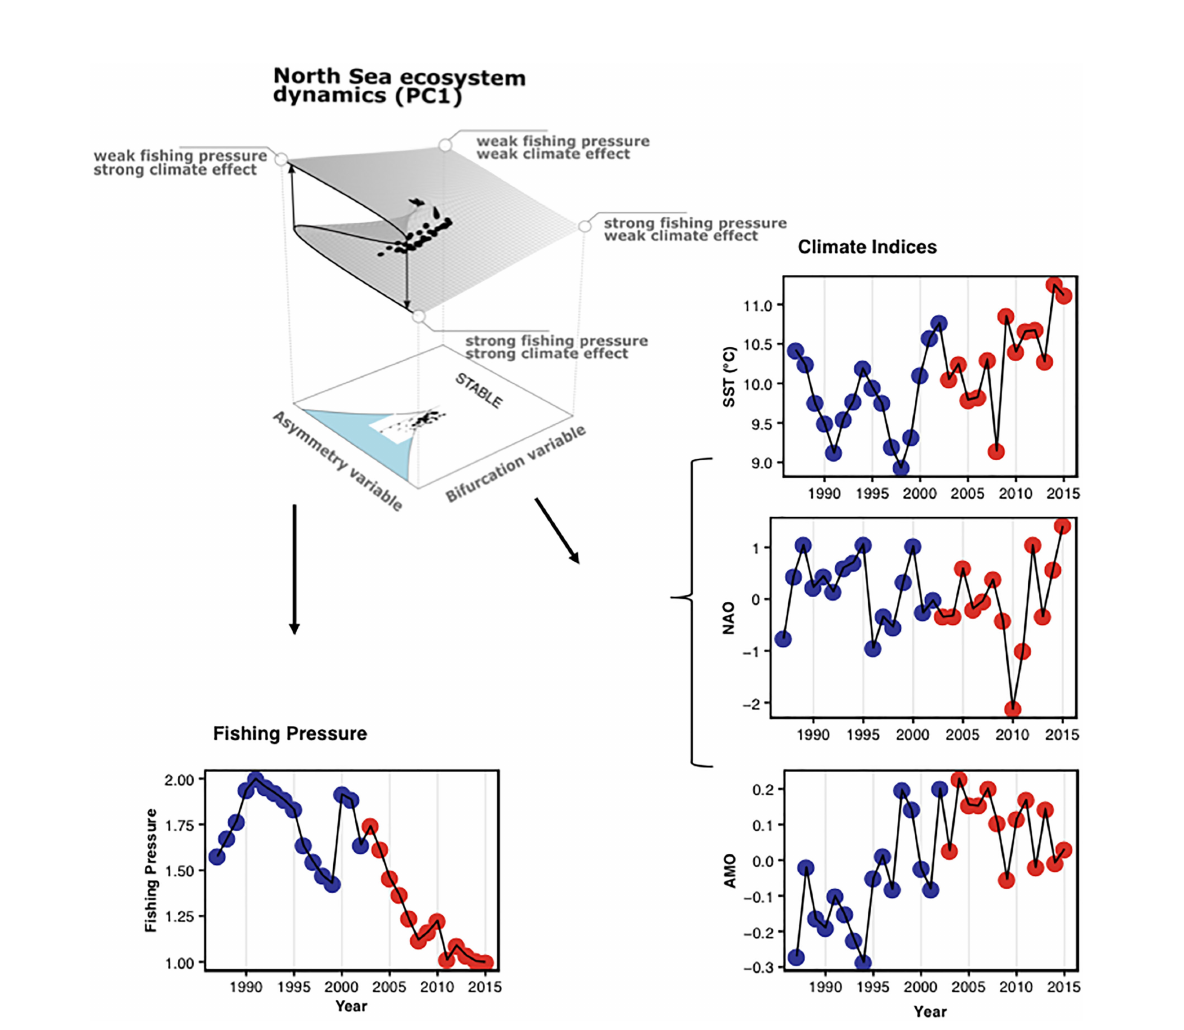
considers a three-dimensional system where a state variable depends on two interacting control variables. The asymmetry variable affects the dimension of the state variable determining its transition between system states. The bifurcation variable determines the form of the relationship between the state variable and the asymmetry variable along a continuum from linear and continuous to non-linear discontinuous. The cusp catastrophe is represented by a potential function that can be fi t to data using the method of moments and maximum likelihood estimators, and the state, asymmetry and bifurcation are canonical variables fi t using linear models of observed quantities (see methods). In our analysis of the North Sea we modelled the dynamics of the state variabl e as a function of PC1 representing the mainmodeofvariabilityintheecosystem.The asymmetry and bifurcationvariables were fi ttotime-seriesof fi shingpressureandclimateindices,respectively.Fishing pressure is represented by the logarithmicvalue of annualtotal hours fi shed (bybeam and bottomtrawls) of theNorth Sea fi sheries. Weused three indices for climate change (colors according to regimes identi fi edin PC1; seeFigure 2), i.e. sea surface temperature (SST) that represents the direct effect ofclimate on the water column, as well as the indices for the North Atlantic Oscillation (NAO) and the Atlantic Multidecadal Oscillation (AMO) that represent decadal and multidecadal climate dynamics, representatively. Our model setup bears the assumption that climate change can alter the relationship between fi shing pressure and ecosystem state from linear to non-linear and vice versa. Importantly, using the stochastic cusp model we can distinguish between unstable (in fact bistable) and stable states in the dynamics of the system. Bistable dynamics exist under the folded curve where the state variable can fl ip between the upper and lower shield, called the cusp area (shaded in light blue) in the 2D representation of the model surface. Outside the cusp area the system is stable and present progressively higher hysteresis as we move away from the